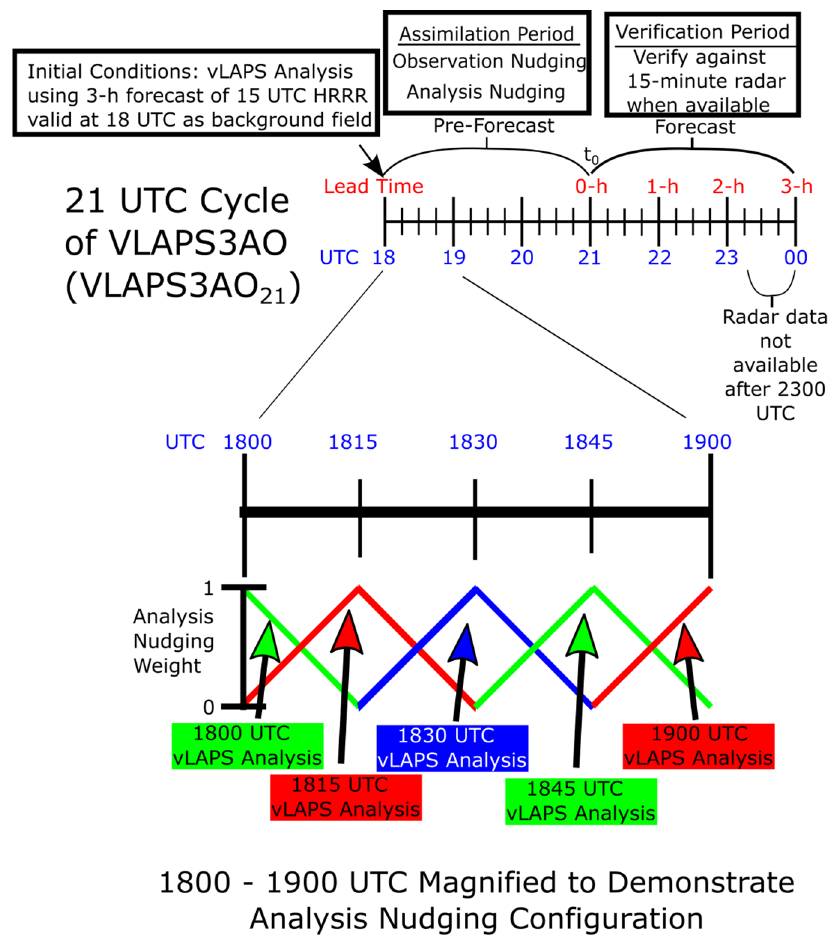
Figure 5. Schematic illustrating the details of a specific experiment (VLAPS3AO) for a specific cycle (21 UTC), i.e., VLAPS3AO 21 . While the lower half of the figure shows the details of how vLAPS analyses were applied using analysis nudging between 1800 and 1900 UTC, analysis nudging towards vLAPS analyses took place throughout the 3 h pre-forecast period.